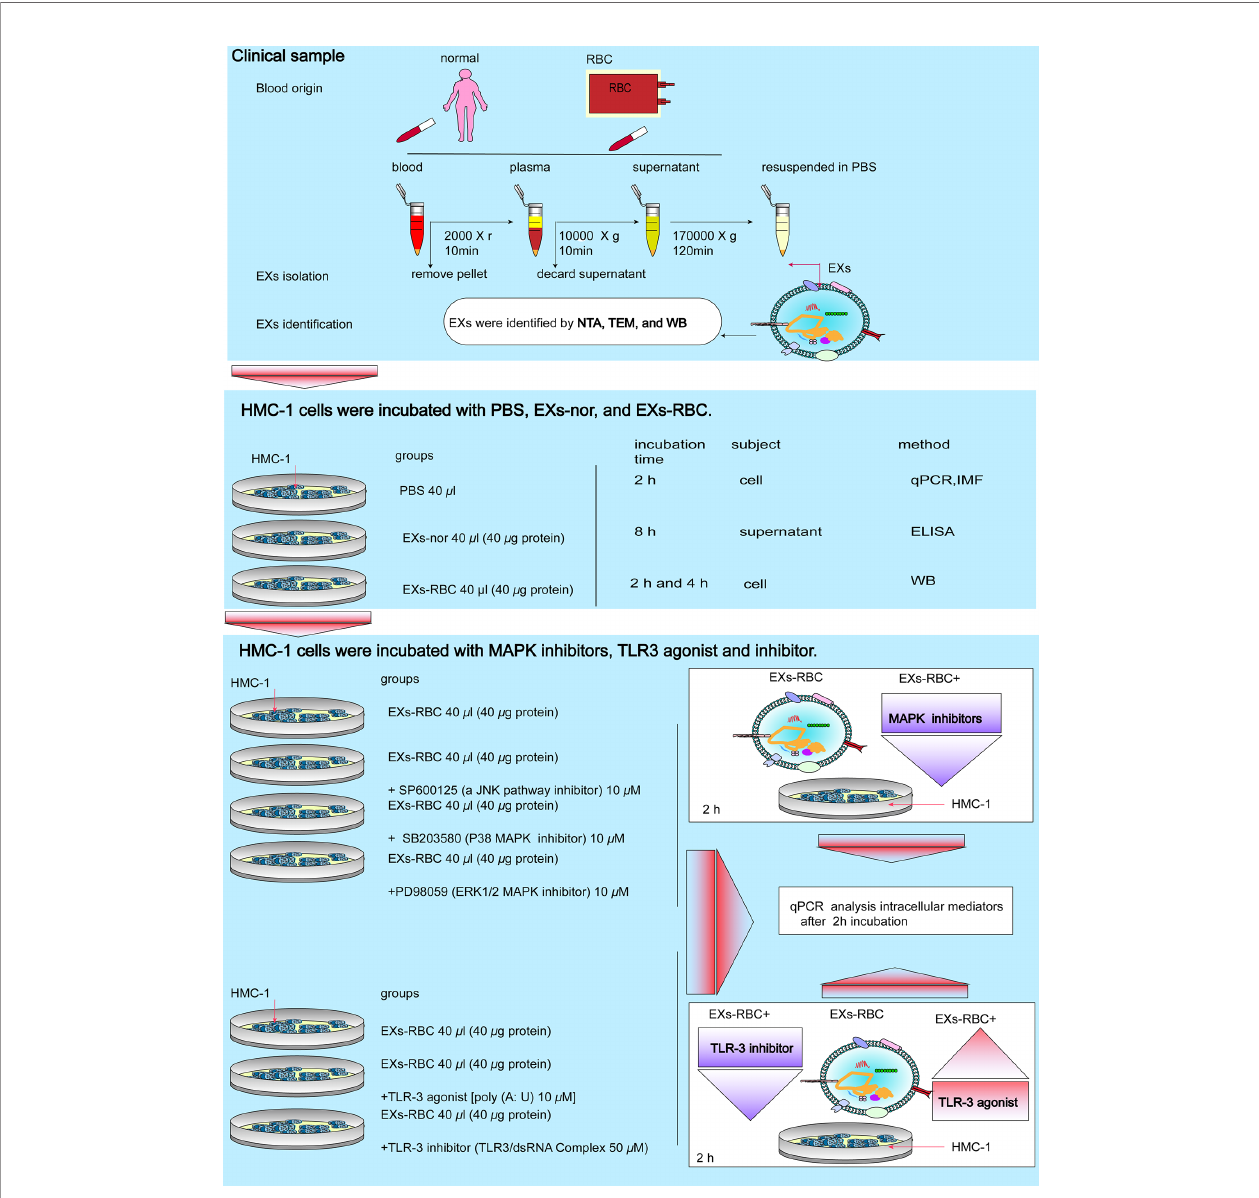
FIGURE 1 | Flowchart of this study. EXs, exosomes; RBC, red cell units; EXs-nor, exosomes from normal volunteer plasma; EXs-RBC, exosomes from red cell units; WB, western blotting analysis; IMF, immuno fl uorescence; qPCR, quantitative real-time PCR; ELISA, enzyme-linked immunosorbent assay; NTA, nanoparticle tracking analysis; TEM, transmission electron